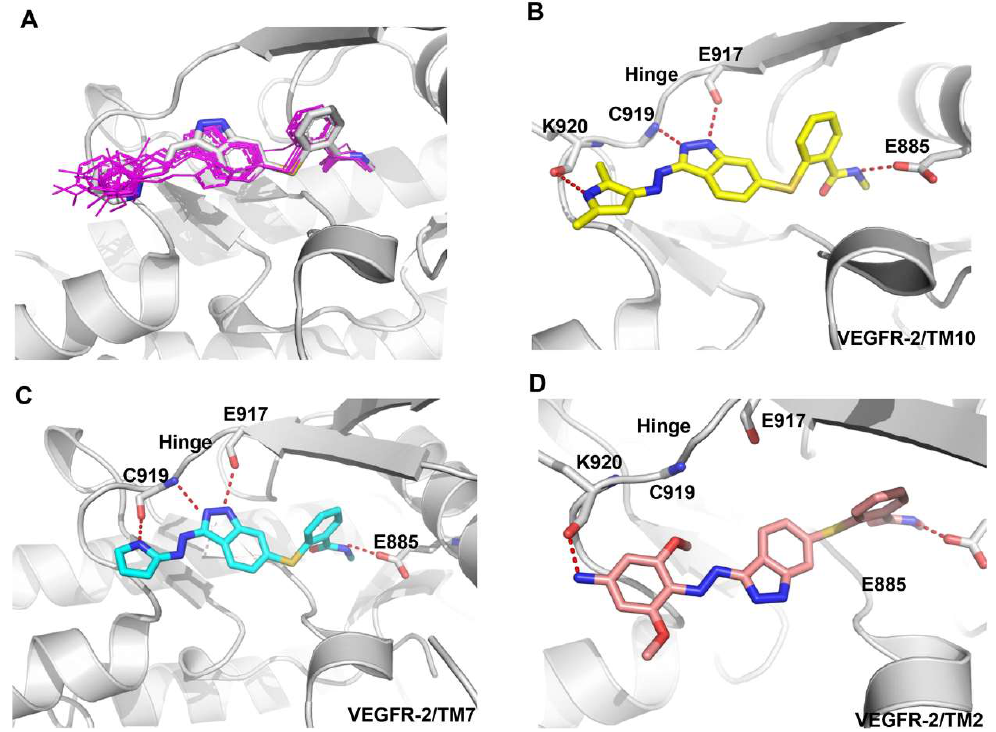
Figure 3. Predicted binding mode of axitinib derivatives in the VEGFR-2 active site (PDB ID Code: